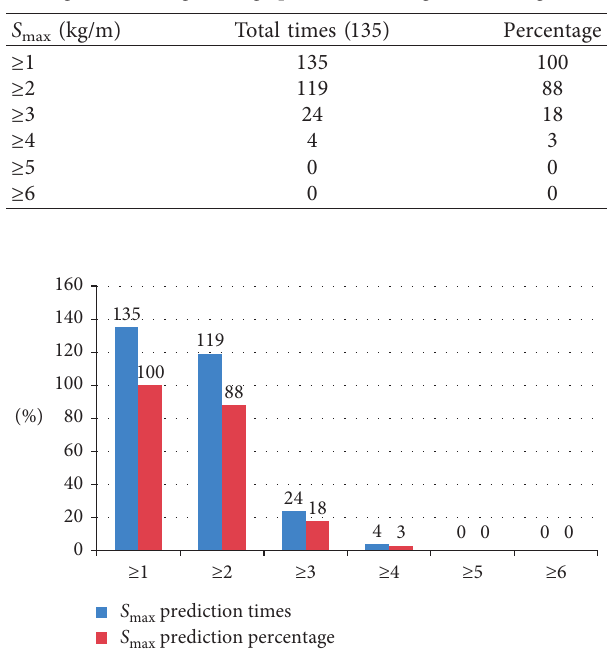
Figure 10: Distribution of range of the index S weight of drilling cuttings predicted during field testing.